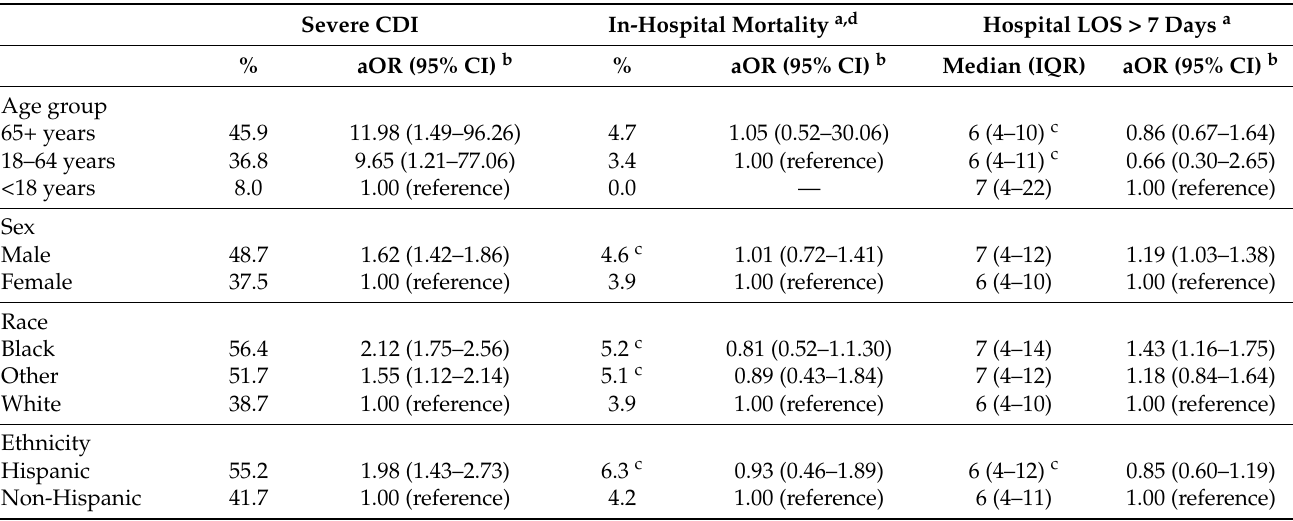
Table 5. CDI outcomes by patient subgroups for recurrent CDI encounters. Severe